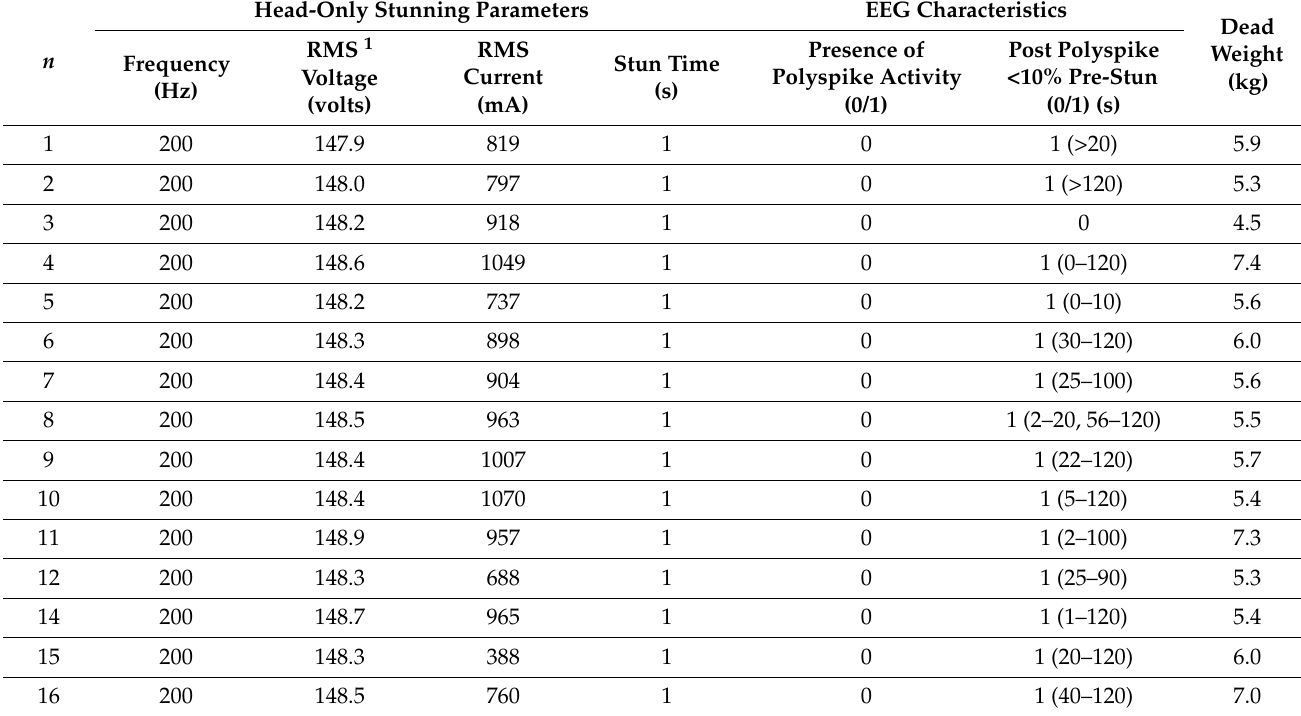
Table 5. The effect of head-only stunning on the expression of epileptiform electroencephalograms (EEGs) in 16 turkeys. Head-Only Stunning n